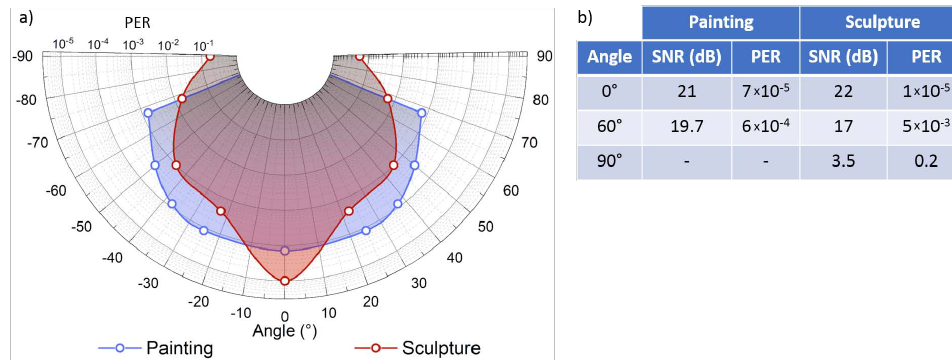
Figure 6. ( a ) Comparison between PER values at 4 m for the wall painting ( Holy Trinity by Masaccio, blue circles) and for marble sculpture ( Holy Water Font by Bordoni, red circles). Solid lines are spline interpolation to data. ( b ) Tabular comparison for relevant angles of 0°, 60°, and